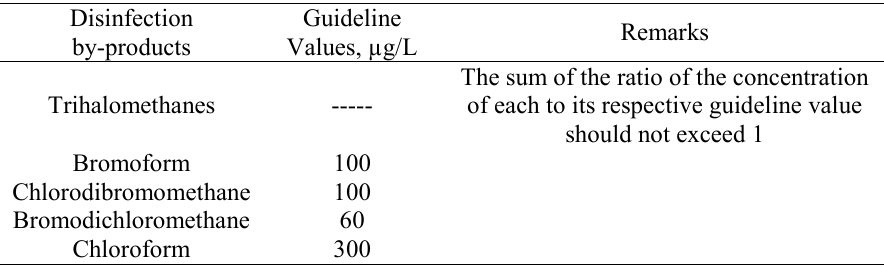
Table 1. WHO guideline values for drinking water quality- 4 th Edition (2011) 12